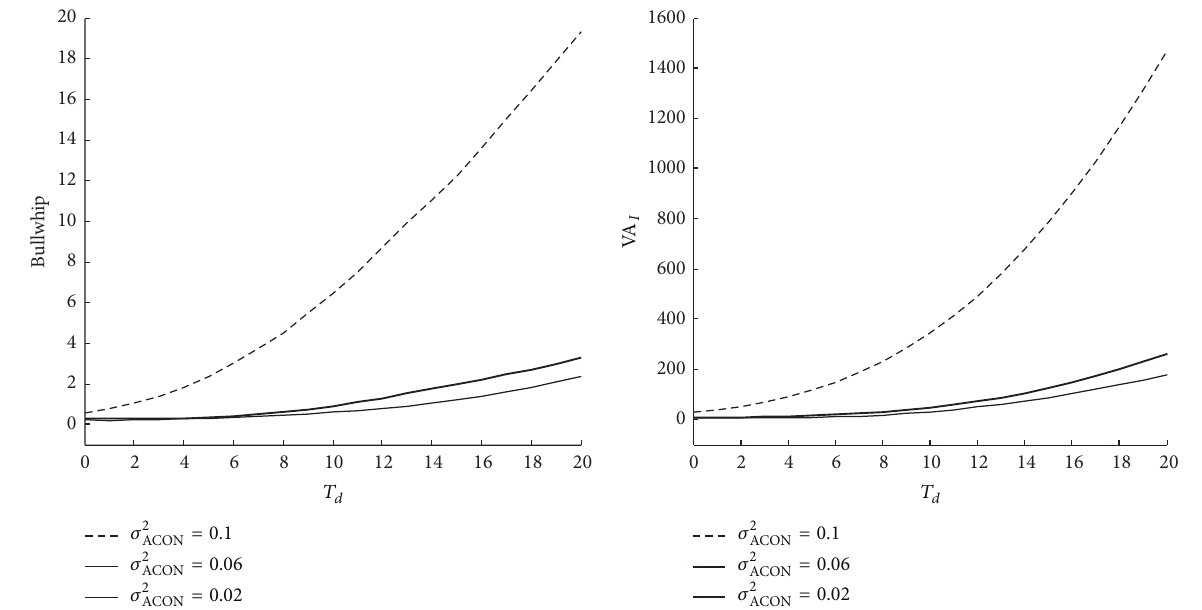
Figure 10: The change situations of Bullwhip and VA 𝐼 by changing 𝑇 𝑑 with fixed 𝜎 2 ACON